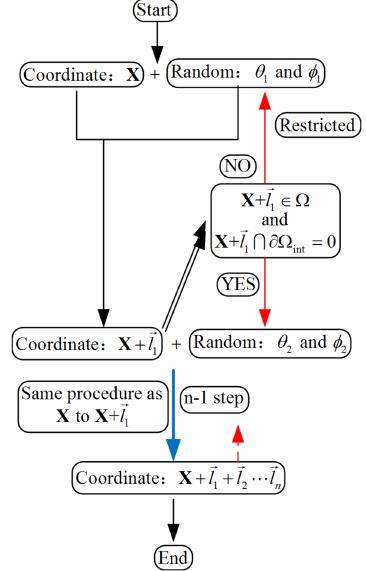
Figure 4. The numerical method used to calculate the probability